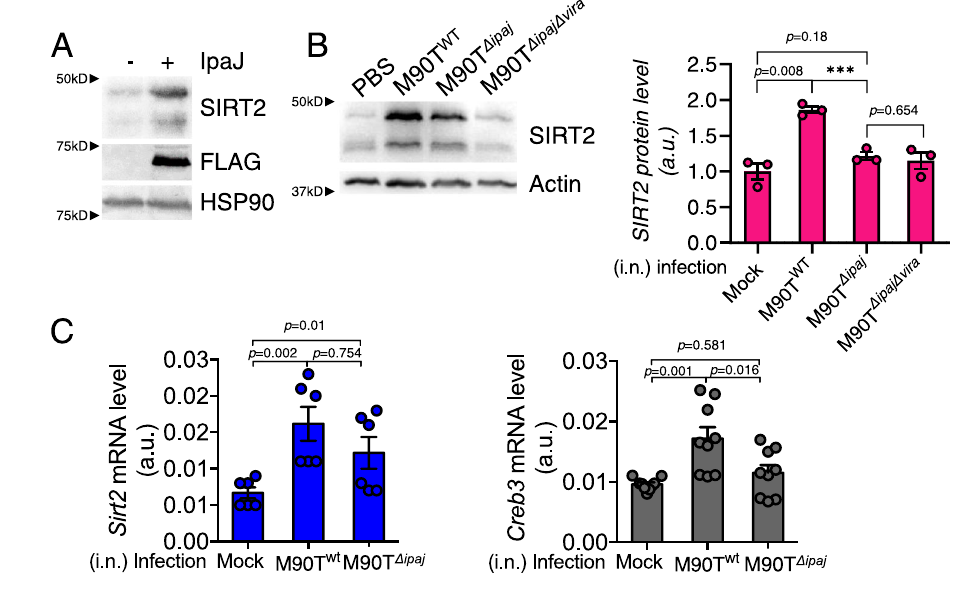
Fig. 3 | Shigella infection upregulates SIRT2 through Golgi stress. A SIRT2 protein level is induced by IpaJ, showing by immunoblots for SIRT2 protein levels in HEK293T cells with or without Flag-IpaJ overexpression. HSP90 is the loading control. B Immunoblots of SIRT2 in BMDMs infected with mock, wild- type or IpaJ deletion S. fl exneri M90T. The BMDMs were derived from 6 to 8-week old wildtype C57BL/6J mice. Quanti fi cation of SIRT2 protein